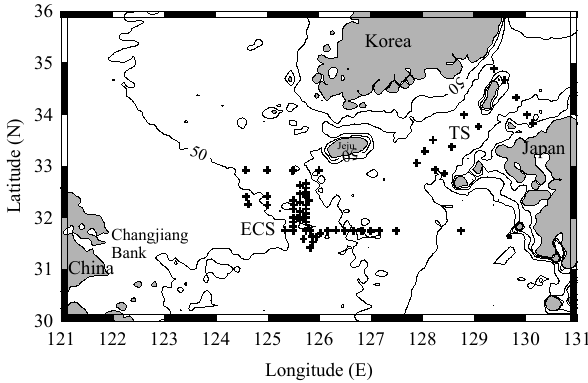
Fig. 1. Locations of the sampling stations in the Tsushima Strait (TS) and in the East China Sea